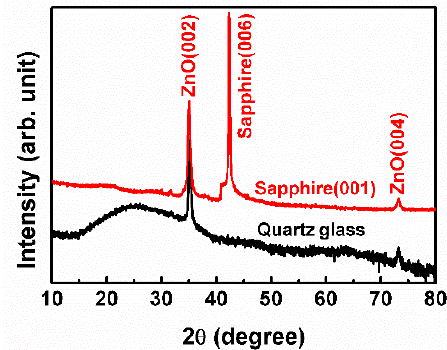
Figure 1. X-ray di ff raction (XRD) patterns of the as-grown ZnO thin films on quartz glass and sapphire Figure 1. X-ray diffraction (XRD) patterns of the as-grown ZnO thin films on quartz glass and (001) substrates annealed at 600 ◦ C for 1 h, sapphire (001) substrates annealed at 600 °C for 1 h, respectively. Table 1. Peak position (2 θ ), lattice constant ( c ), full width at half maximum (FWHM), calculated grain size ( D ), dislocation density ( δ ), and stress values ( σ ) of the as-received ZnO thin films grown on the quartz glass and sapphire (001) substrates with an annealing treatment of 600 °C for 1 h.